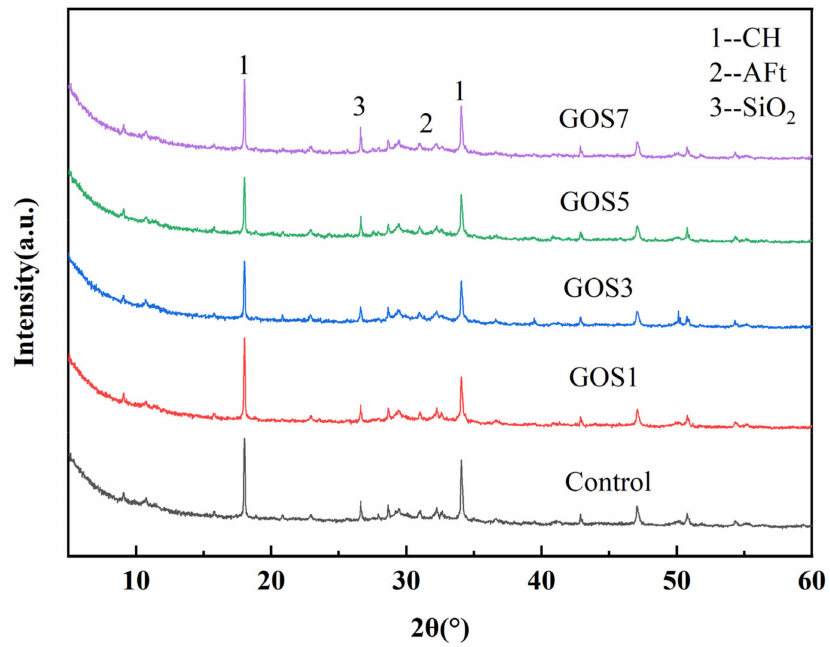
Figure 11. XRD patterns of cement-based materials with different GOS concentrations.